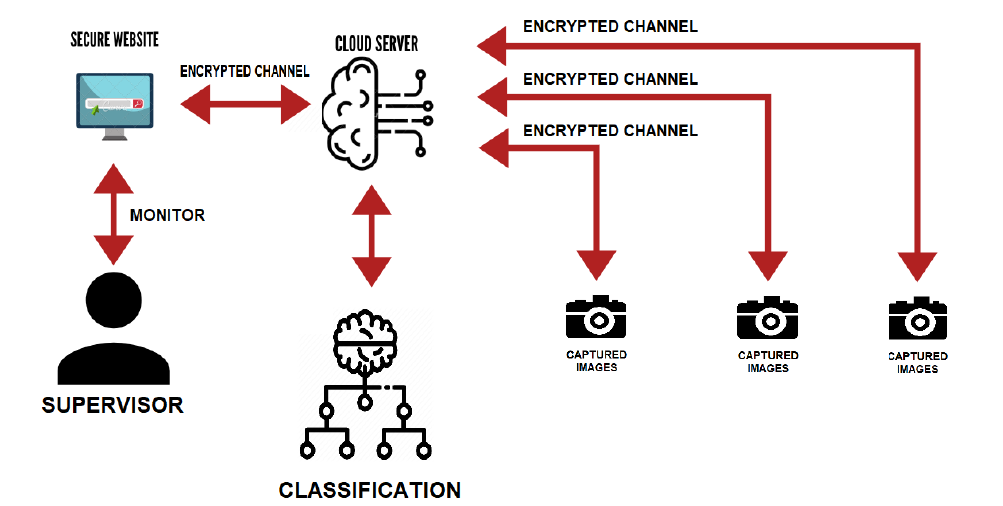
Figure 1. In the proposed system architecture, captured images are being offloaded to the cloud for the classification